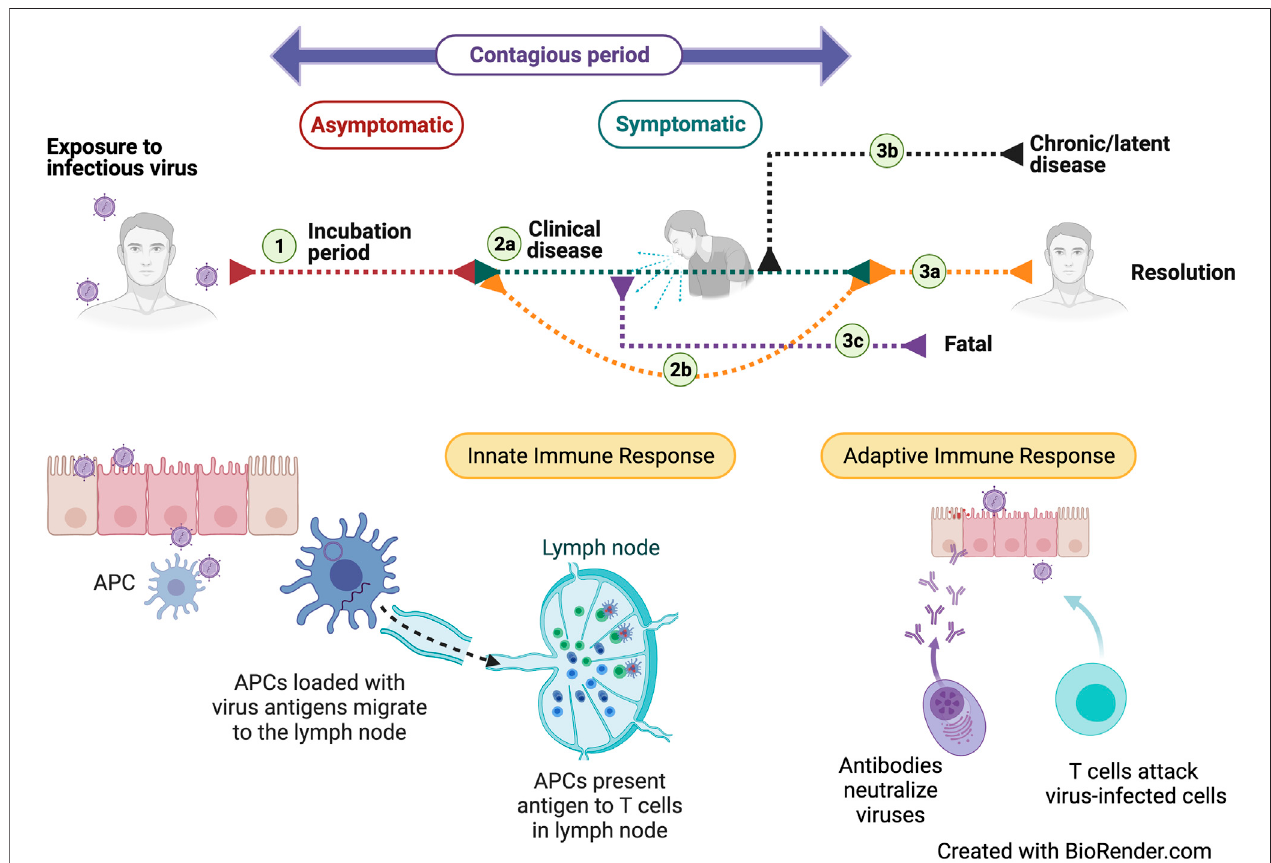
FIGURE 3 | Course of disease and the associated immune responses after exposure to an infectious virus. Exposure to an infectious virus is followed by an asymptomatic incubation period (1) during which the virus replicates. During this phase, the tissue-resident innate immune responses are initiated but may still allow diseasesymptomstodevelop(2A).Stimulationofprotective,adaptiveimmuneresponsesresultsinresolution(3A)ofthedisease.Insomecases,thepatientmayremain asymptomatic (2B) because of a strong adaptive immune response. Certain viruses can transition to a chronic disease (3B) while others may have a fatal outcome (3C). Successful immune responses may also lead to viral clearance.